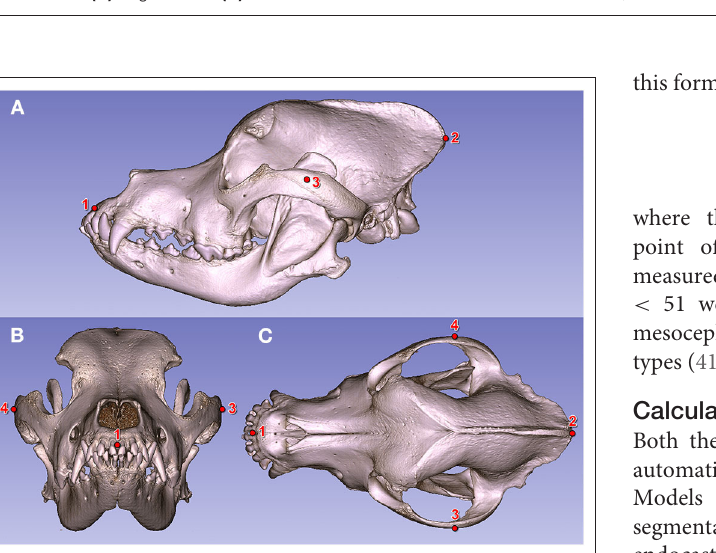
FIGURE 5 | Projecting the surface mesh (marked with orange) onto the Saint Bernard’s skull and checking its fitting on the orthogonal views. (A) Transverse view. (B) Dorsal view. (C) Sagittal view. (D) 3D model of the endocast of a Saint Bernard skull, left lateral view.